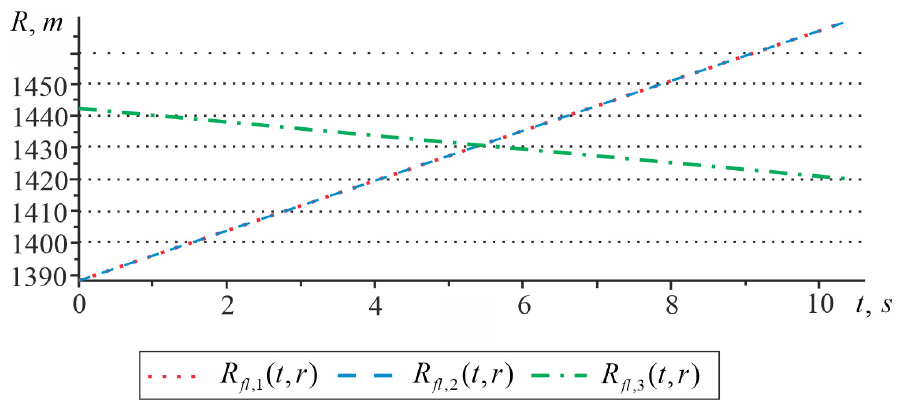
Figure 4. Variation in current distances along each of the beams (first simulation).